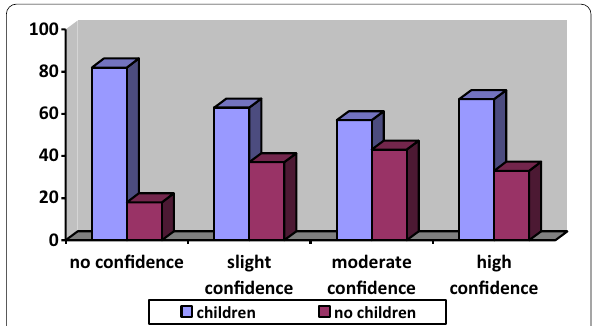
Fig. 10 Confidence to pay next month’s installment in terms of having